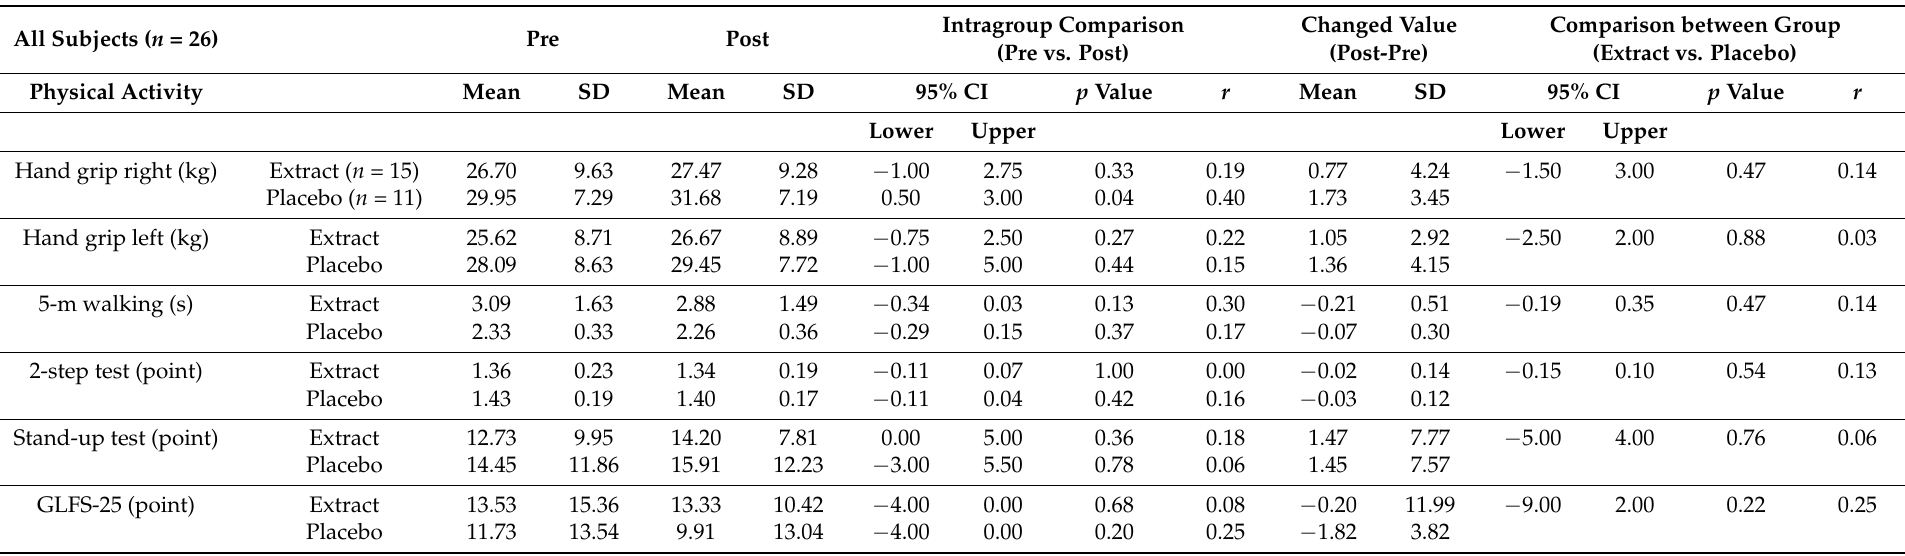
Table 4. Comparison of physical activity scores in all